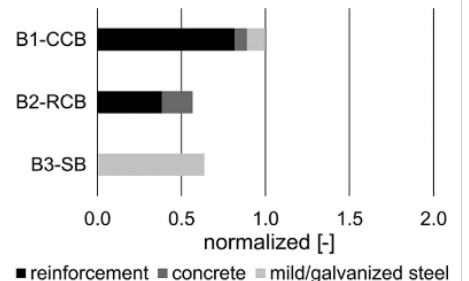
Figure 11. Comparison of the AP of various pedes- trian bridge types (normalized values) divided by the used building materials, extracted from [5].